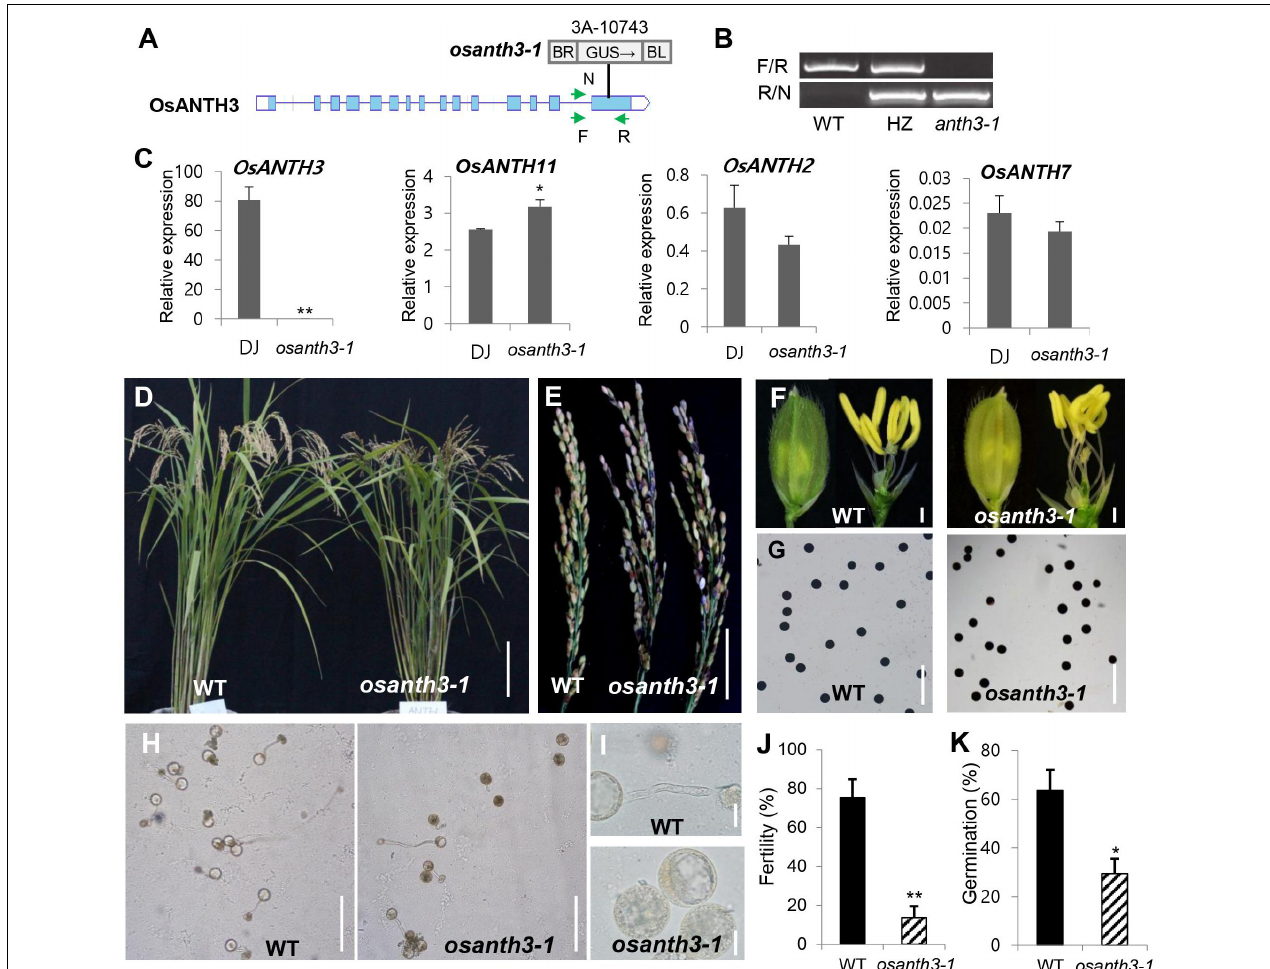
FIGURE 5 | Phenotypes of plants containing mutations in AP180 N-terminal homology (ANTH) domain-containing protein-coding gene 3 in Oryza sativa ( OsANTH3 ) ( LOC_Os02g07900 ). (A) Schematic diagram of the osanth3-1 mutant with T-DNA insertion. (B) Polymerase chain reaction (PCR) analysis for genotyping using two primer sets (F/R and R/N). Genotyping results showed that osanth3-1 was homozygous. (C) qRT-PCR for four genes ( OsANTH3, OsANTH11, OsANTH2, and OsANTH7 ) in Dongjin (WT) and osanth3-1 . Rice ubiquitin 5 ( OsUbi5 , LOC_Os01g22490 ) was used as an internal control. The y -axis shows the expression level relative to OsUbi5 , while the x -axis shows the samples used for analyses. Error bars represent the standard errors of three biological replicates. (D) Vegetative growth was not significantly different between the WT and osanth3-1 , but osanth3-1 shows partial male sterility. (E) Panicle of the osanth3-1 mutant observed with many empty grains due to poor germination. (F) Whole spikelet (left side) and spikelet after removing lemma and palea (right side) of osanth3-1 are similar to those of the WT. (G) Pollen grains of the WT and osanth3-1 mutant stained with KI solution exhibited normal starch accumulation. (H,I) Microscopic photograph of pollen germination in the WT and osanth3-1 mutant. Compared with that in the WT, osanth3-1 exhibited a lower germination percentage (J) . Fertility rate was calculated as (average of the number of seeds normally germinated)/(total seeds) × 100 for each panicle. (K) The germination rate was calculated as (the average of the number of germinated pollen)/(total pollen) × 100, n = 100. Significant differences are indicated by asterisks; * p < 0.01 and ** p < 0.0001. Scale bars, 10 cm in (D) ; 5 cm in (E) ; 10 µ m in (F) ; and 20 µ m in (I) ; Bars = 200 µ m in (G,H) . Error bars represent the standard errors of three biological replicates (C,J)